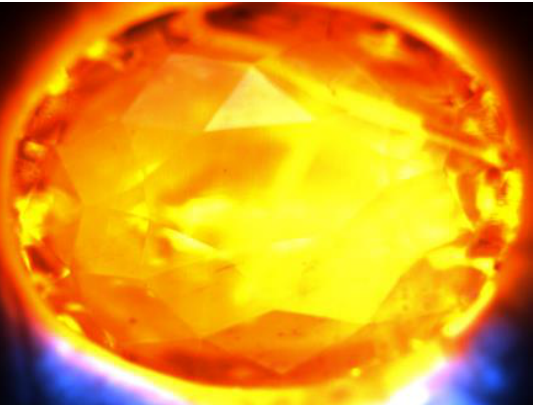
Figure 5. Some samples show orange-red fluorescence under long-wave ultraviolet.